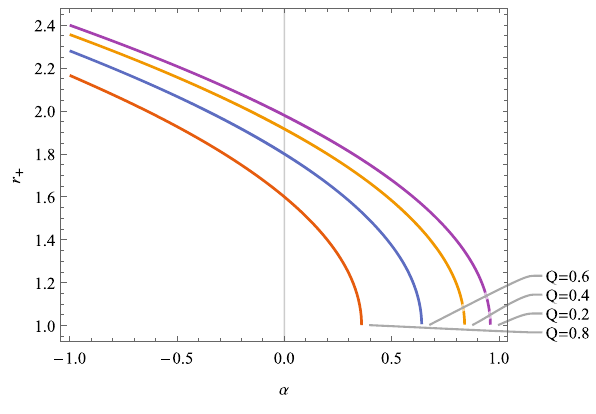
Fig. 1 Plot of r + versus